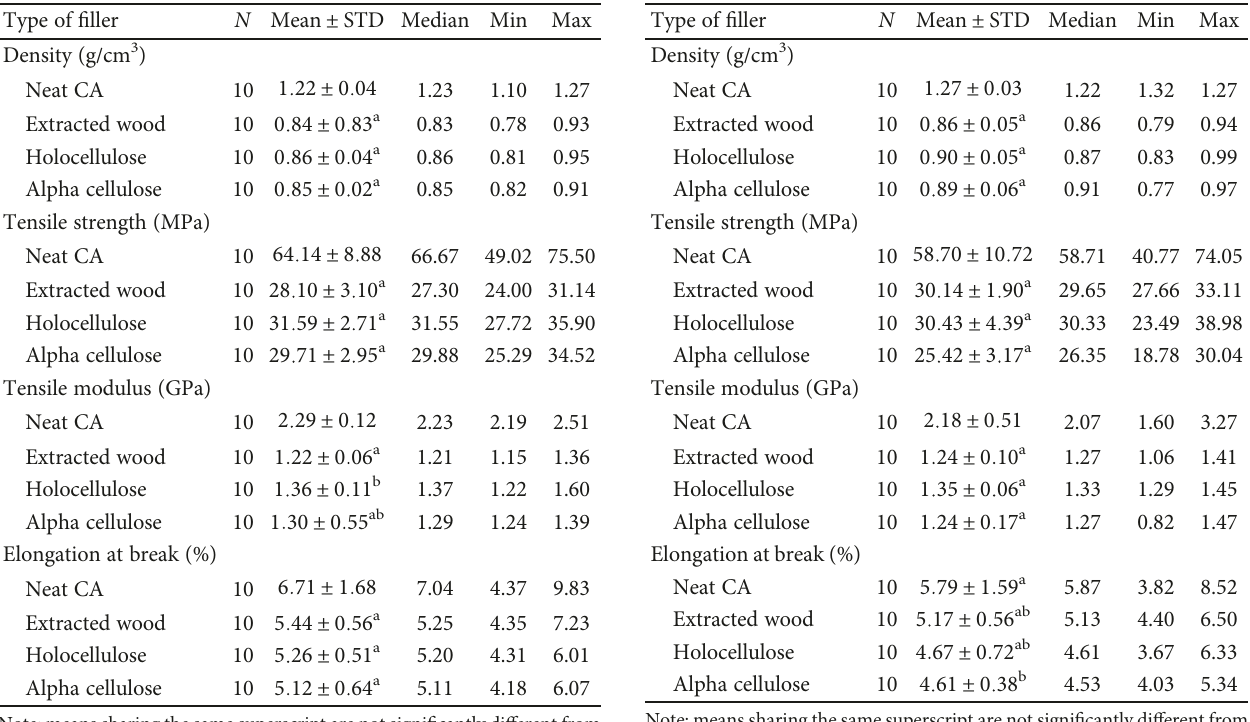
Table 5: Density and mechanical properties of biocomposites prepared from white willow.